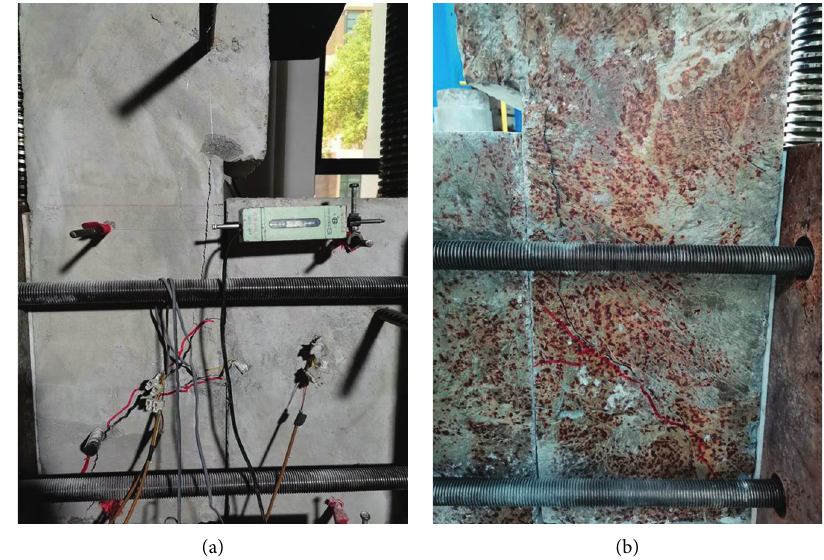
Figure 9: Crack propagation of DS2. (a) Section A and (b) section